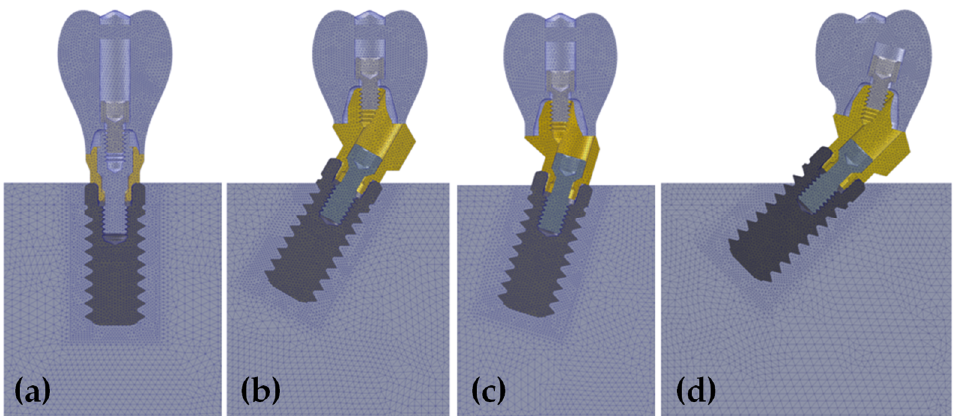
Figure 2. Finite element analysis mesh of single-unit implant placed axially ( a ), 17°—tilted ( b ), 30°—tilted ( c ) and 45°—tilted ( d ).